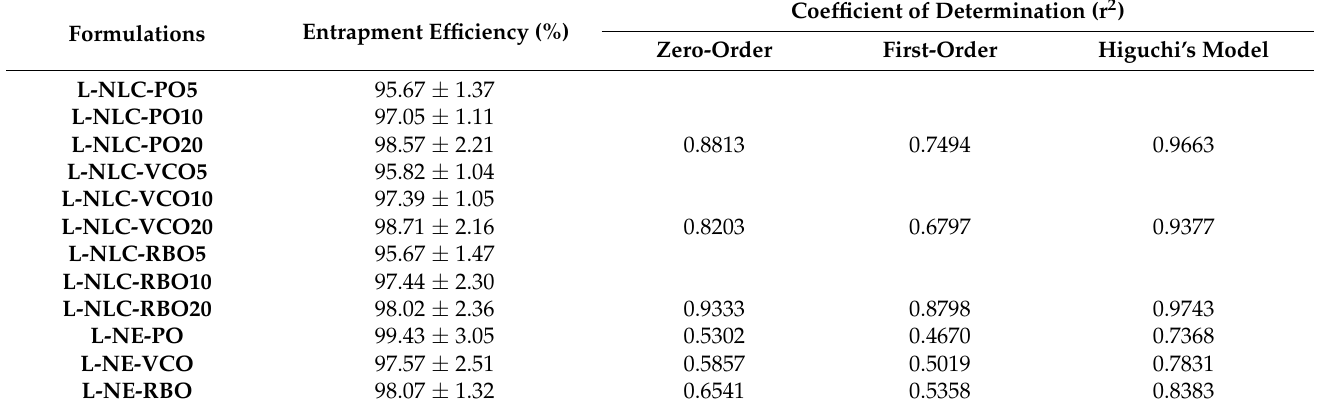
Table 4. The %E.E. of lutein and coefficient of determination (r 2 ) of release kinetics of lutein release from L-NLC and